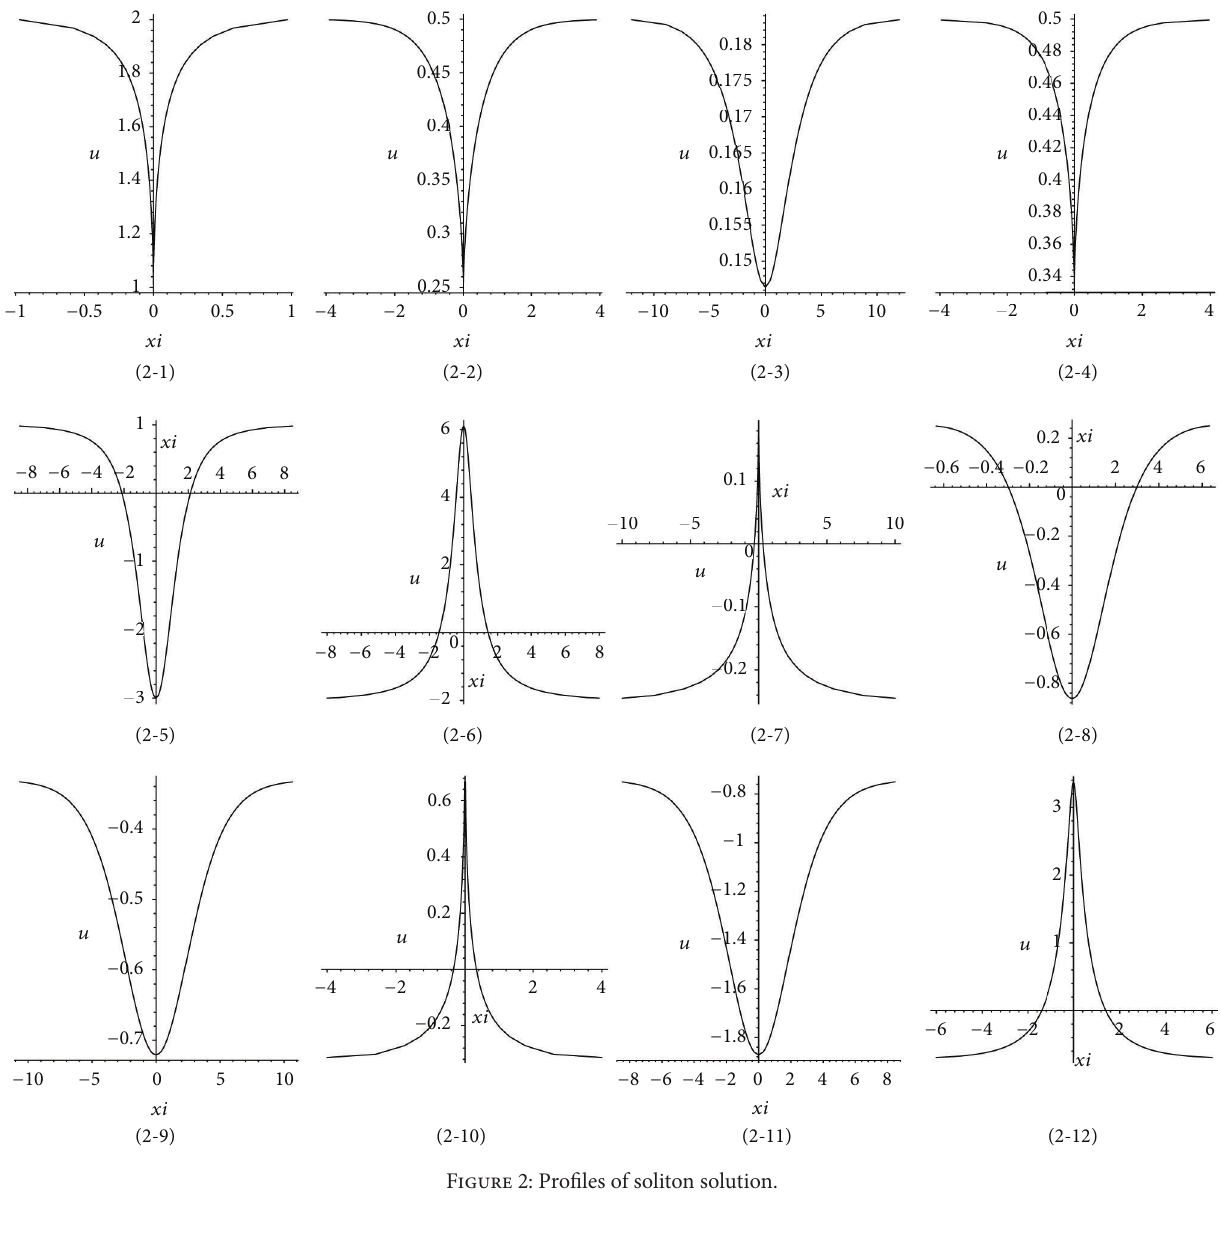
Figure 2: Profiles of soliton